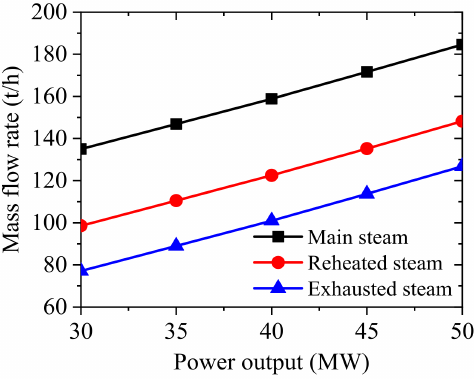
Figure 8. Effect of power output on the mass flow rates of main, reheated, and exhausted steam.